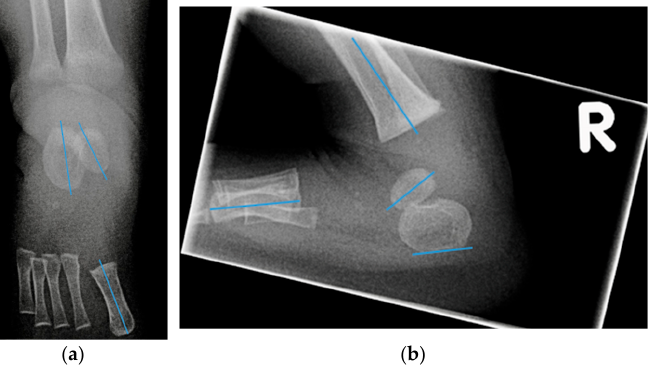
Figure 1. Radiograph obtained at the age of three months: ( a ) anteroposterior radiograph with lines through the longitudinal axis of the talus, calcaneus, and 1st metatarsal; ( b ) lateral radiograph with lines through longitudinal axis of the tibia, the talus, the 1st metatarsal, and the plantar aspect of the calcaneus.